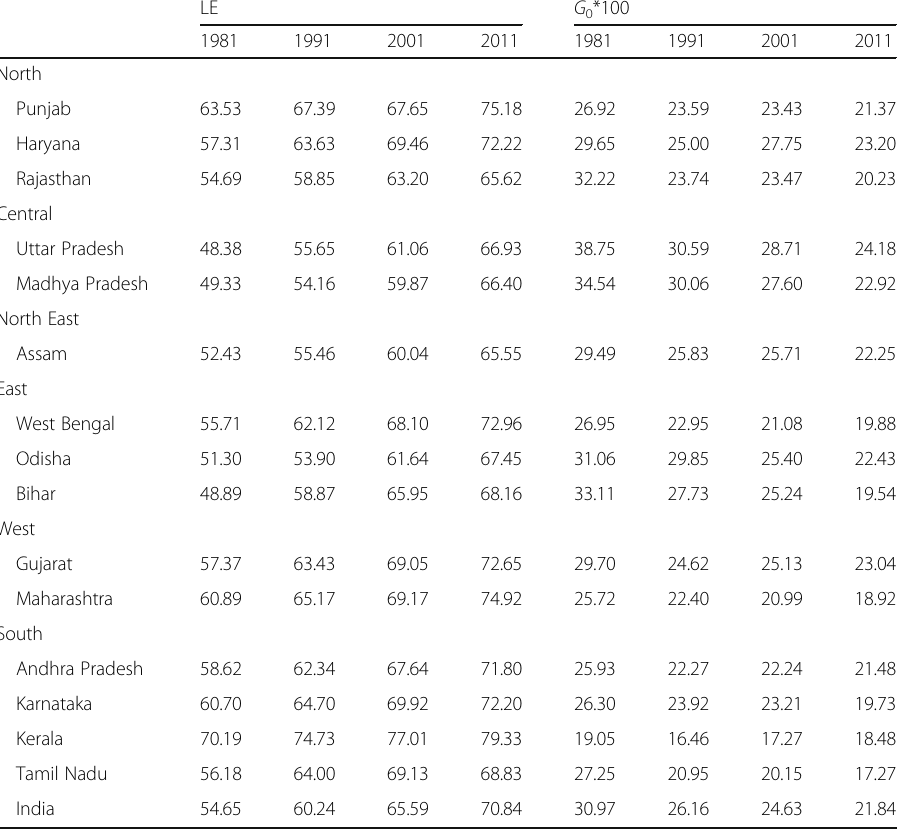
Table 2 Life expectancy (LE) at birth and Gini coefficient of LE from 1981 to 2011, India and major states, women